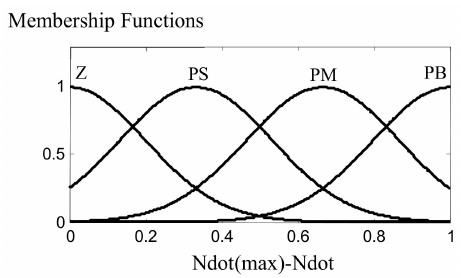
Figure 8. Second input membership functions.